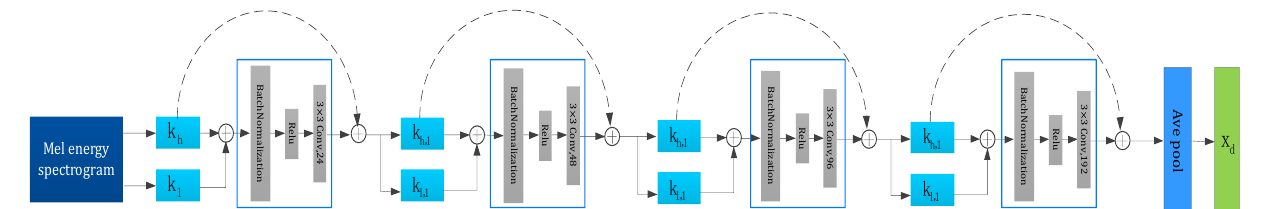
Figure 5. MFF-ResNet. The inputs of MFF-ResNet are log-Mel spectrogram features and manual design features. The two branch outputs of the spectrogram features were used for frequency fusion with rResNet (as shown in Figure 6). The more abstract features are obtained by the bi-level atten- tion module, which includes a features enhancement and a fusion module (as shown in Figures 7 and 8, respectively). The fused features are then passed through the feature classifier to produce the final classification results.